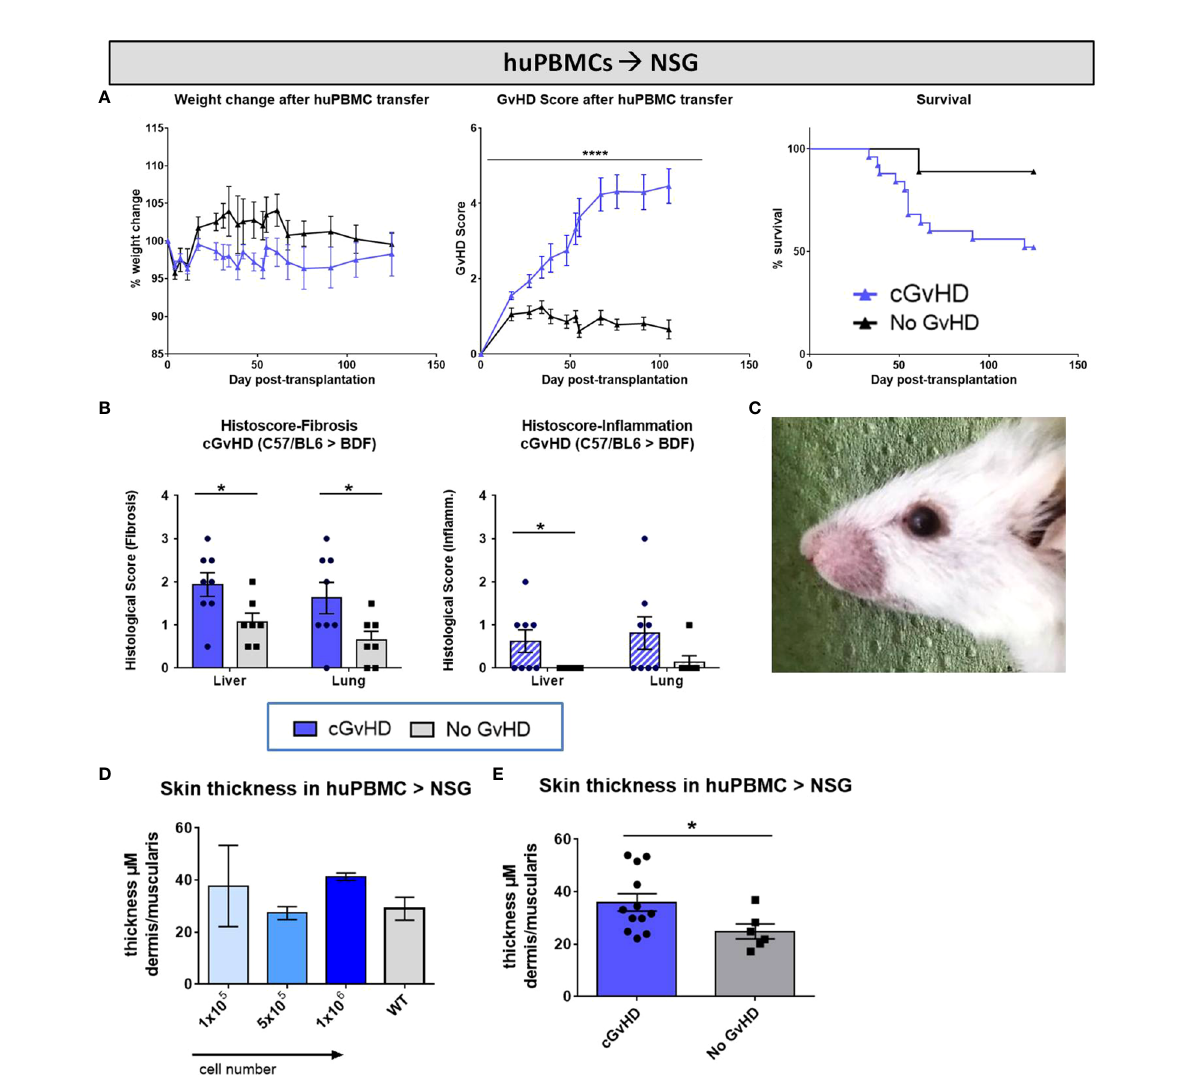
FIGURE 13 Clinical organ manifestations of cGvHD in huPBMCs ➔ NSG at day +125 after allo-HCT. (A) Clinical cGvHD was estimated by frequently assessing weight change (left), GvHD score (middle) and survival (right). Animals were regularly scored for fi ve clinical parameters (weight loss, posture, activity, fur and skin) on a scale from 0 to 2. Clinical GvHD score was summarized of all fi ve parameters. Error bars show mean ± SEM. n=20 (cGvHD), n=8 (no GvHD). Representative data from one out of two experiments. ****P<0.0001 by unpaired students t-test. Survival was tested by Mantel-Cox-log-rank test. (B) Histological quanti fi cation of fi brosis and in fl ammation in liver and lung, based on histo-scoring ranging from 0= no to 4= severe fi brosis/in fl ammation. Error bars show mean ± SEM. n=8 (cGvHD); n=7 (No GvHD). Representative data from one out of two experiments. *P<0.05 by unpaired students t-test. (C) Exemplary photo of eye-involvement in cGvHD pathology. Eyes showed signs of blepharitis and dryness and opaci fi cation of lenses. (D) Skin thickness was not affected by varying transplanted huPBMC-doses, but was (E) increased in cGvHD vs. non-GvHD. Thickness was estimated by measurement of dermis-muscularis-ratio in Masson ’ s Trichrome stainings. Error bars show mean ± SEM. n=12 (cGvHD); n=6 (No GvHD). Pooled data from three independent experiments. *P<0.05 by unpaired students